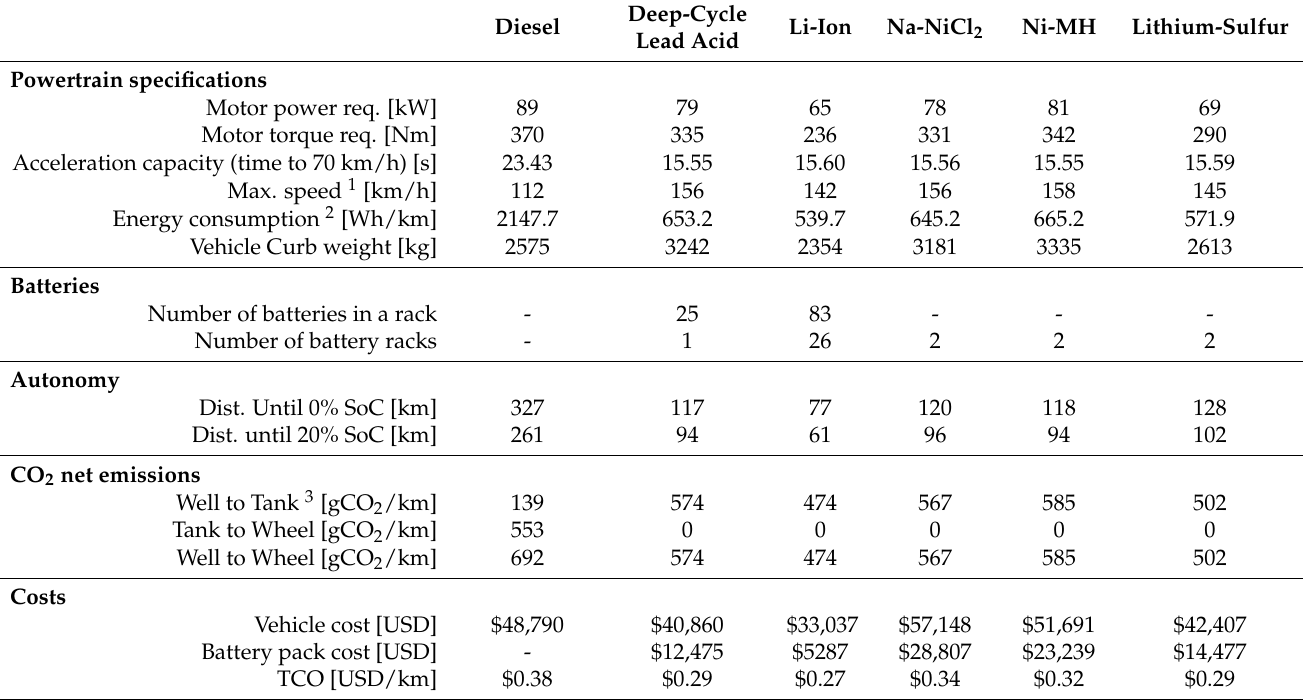
Table 7. Resulting vehicle performance metrics of the optimized gearbox for CircuitoTec considering the typical SFC scenario and an autonomy >50